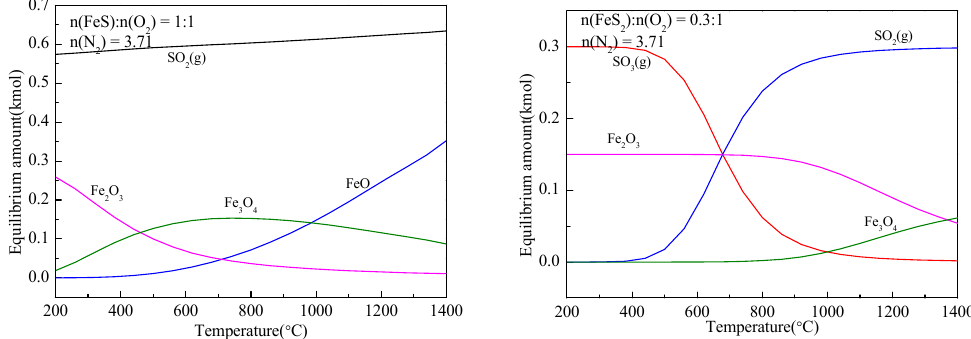
Figure 4. Equilibrium amounts of species as a function of temperature for reaction of FeS 2 and O 2 .